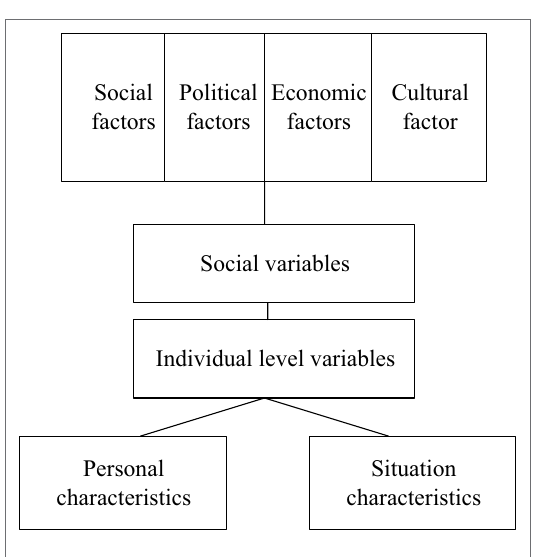
FIGURE 3 | The process of cross-cultural